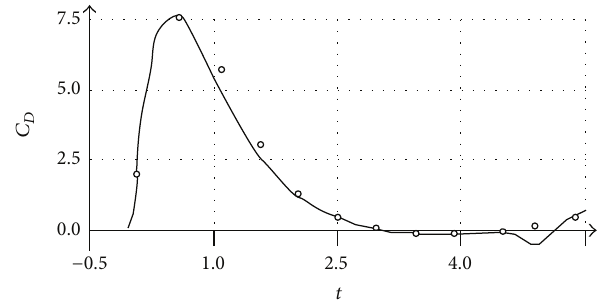
Figure 4: Profiles of computed 𝐶 𝐷 compared with experimental data.Solidline:presentnumericalresults;opencircles:experimental results of Sun et al. [9].